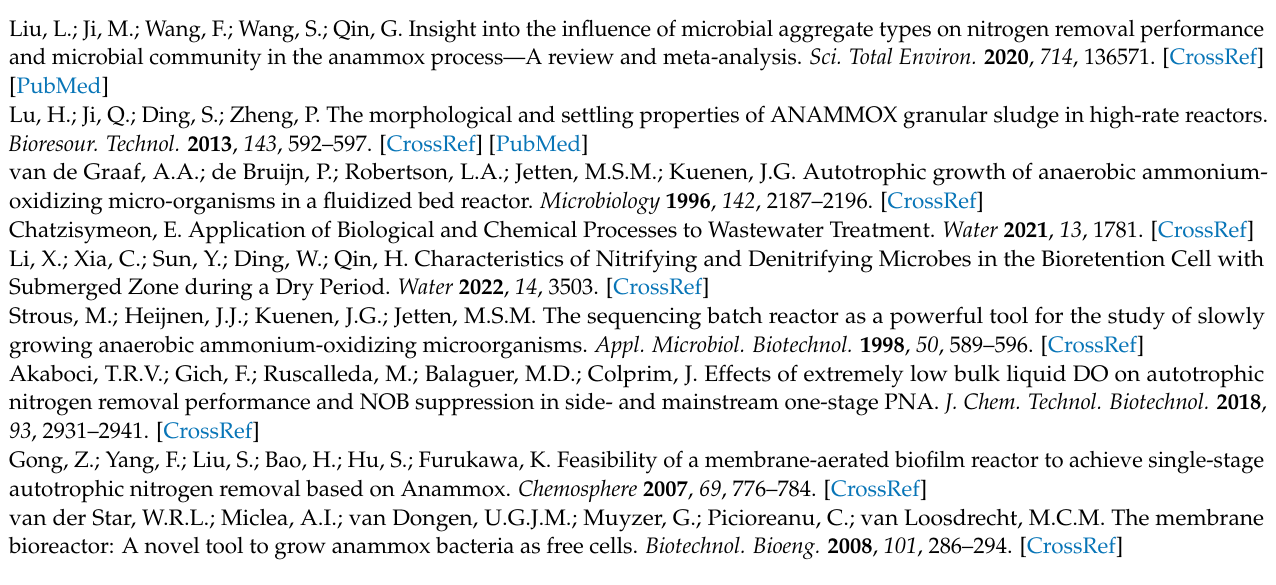
ceramic MBR. Figure S1: Deionization flux of ceramic membrane. Figure S2: SEM images of ceramic membrane surface. ( a ) New membrane; ( b ) with cleaning equipment; ( c ) without cleaning equipment. Figure S3: FTIR images of ceramic membrane surface. Figure S4: Changes in MLSS, MLVSS, and MLSS/MLVSS during operation. Figure S5: pH and DO in the ceramic membrane bioreactor. Figure S6: Changes in ammonia removal rate (ARR) and nitrite oxidizing rate (NOR) in the ceramic membrane